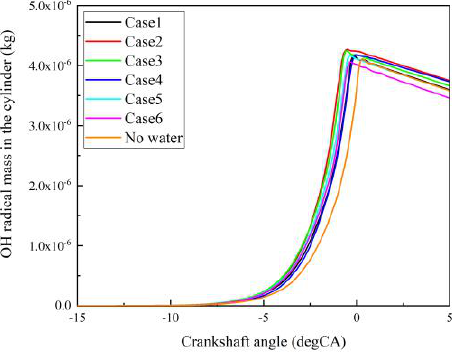
Figure 13. Pressure curves of eight monitor points in different water injection cases (CR = 10.3, igni- tion time = − 14 degCA).